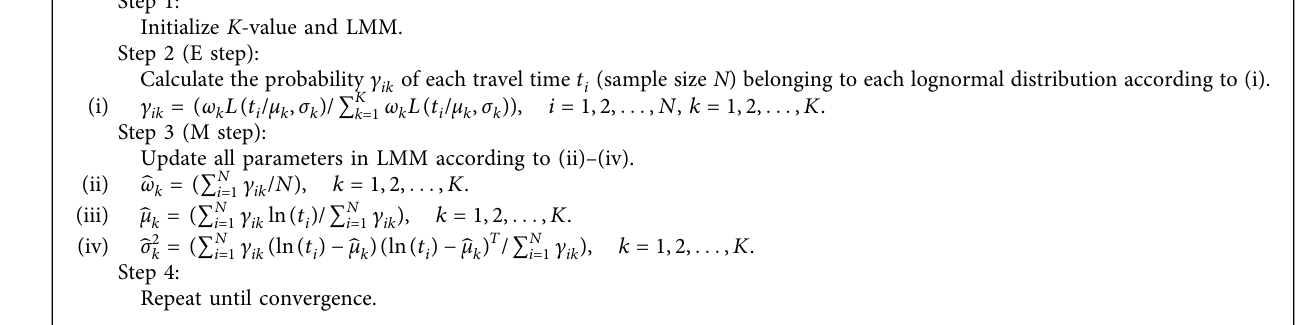
Table 4: Summary of median and trimmed mean of BI-values and BI variation ratio under six weather conditions.